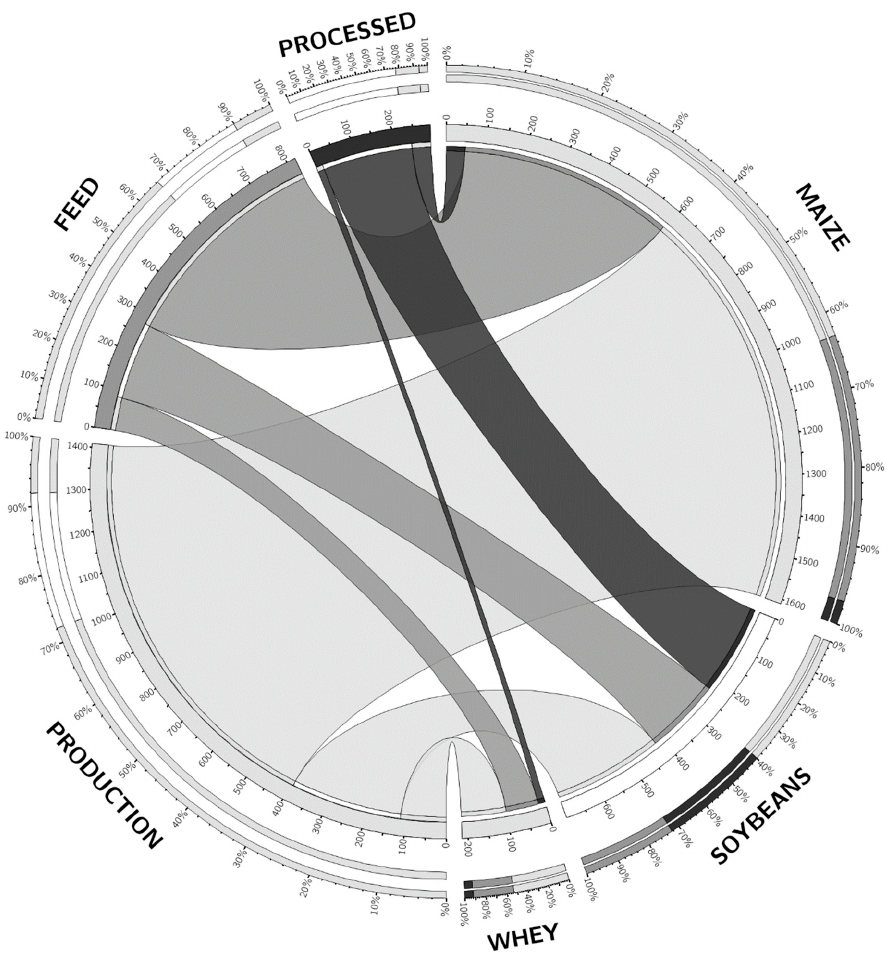
Figure 2. The segmentation of maize, soybean, and whey volume into feed and processing supply chains. The inner scale of the synteny diagram show the accumulated mass of product in million tonnes produced each year, the outer scale shows relative percentage of production, processing, and feed [7,10]. The synteny diagram has been developed using the open source Circos on-line programme [10].